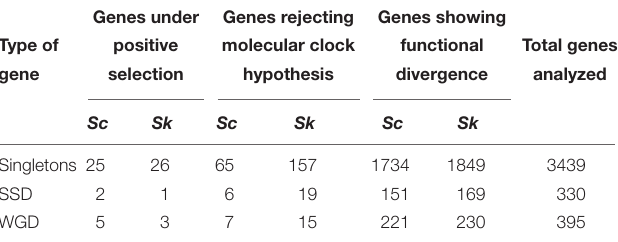
TABLE 2 | Number of genes with a positive result in positive selection, functional divergence and Tajima’s relative rate test